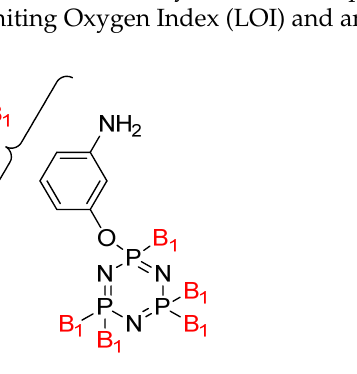
Figure 4. Structure of hexa(aminophenyl)cyclotriphosphazene .